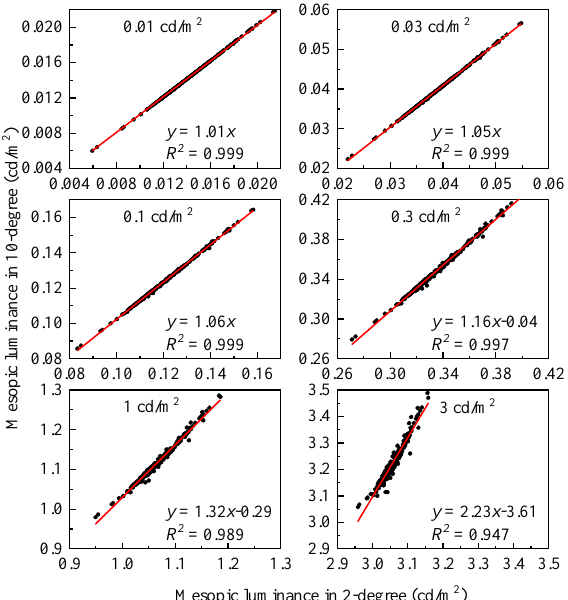
Figure 5. Mesopic luminance plots of the 10- against the 2-degree systems at the reference photopic adaptation luminance levels of 0.01, 0.03, 0.1, 0.3, 1, and 3 cd/m 2 . The reference photopic adaptation luminance level is included in the 2-degree SSC system. Accordingly, corresponding photopic adaptation luminance values in the 2-degree SSC system should be multiplied with the conversion coefficient R sp (2-degree)/ R sp (10- degree).